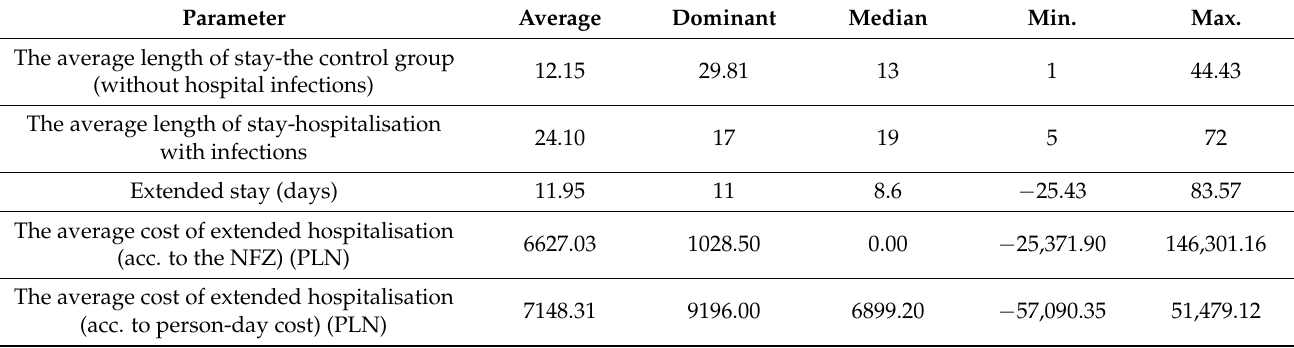
Table 3. Assessment of the average extended duration of stay and costs related to a nosocomial Clostridioides difficile